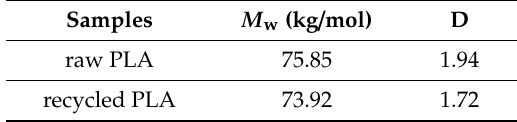
Table 6. Molecular weight variation in PLA before and after